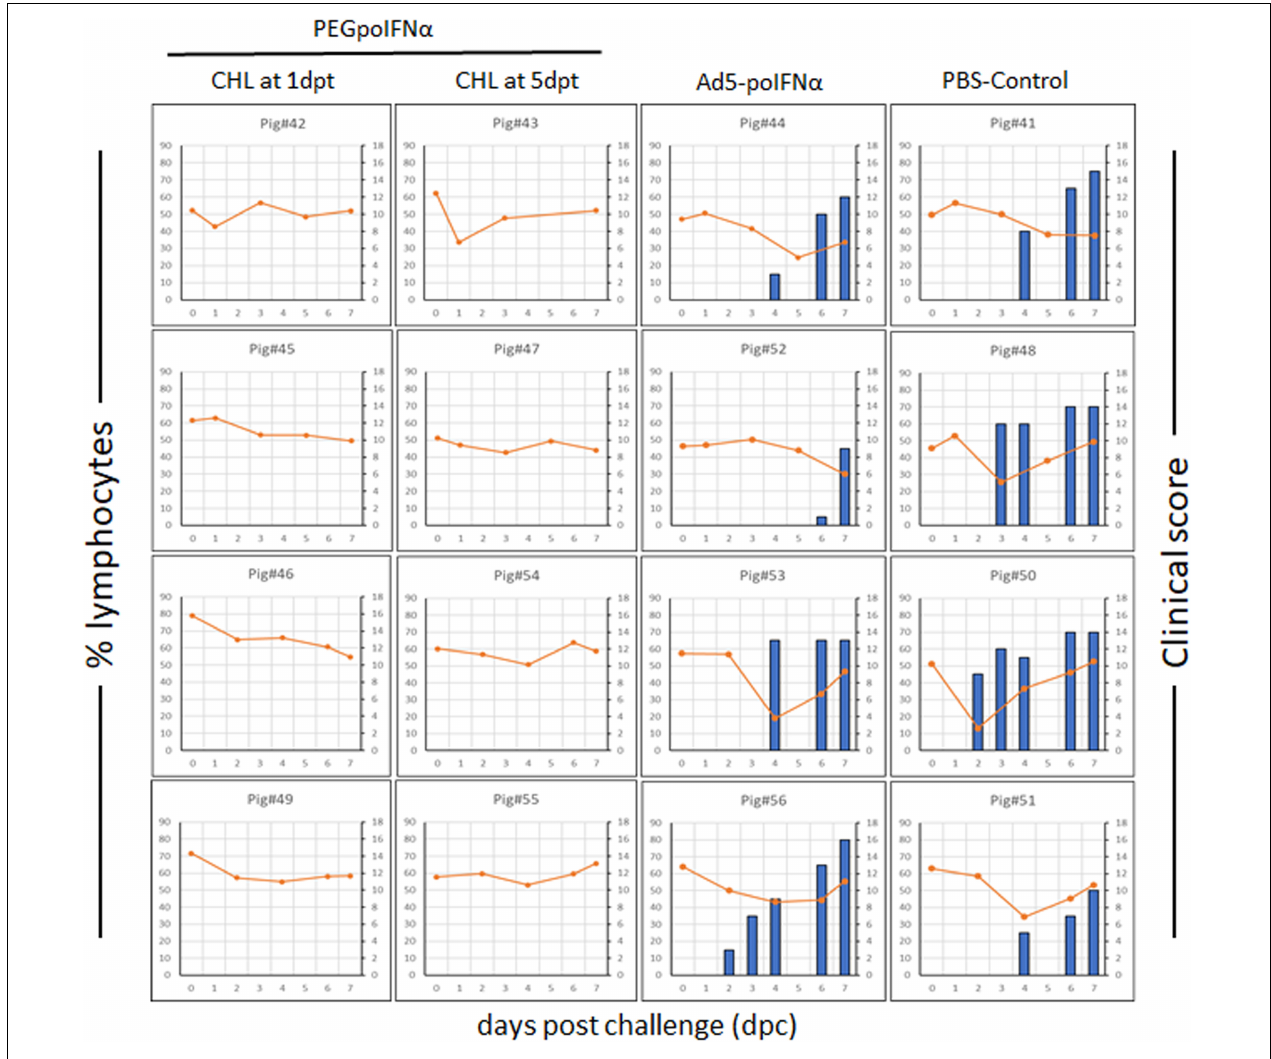
FIGURE 3 | Clinical outcome in animals after challenged with FMDV A24Cru. 18–23 kg castrated male Yorkshire swine ( n = 4/group) were clinically monitored for 7 days after challenge intradermally (ID) in the heel bulb with FMDV A24Cru and samples of heparinized blood were collected daily. Clinical score (blue bars) and % of lymphocytes (orange line) are represented for each animal